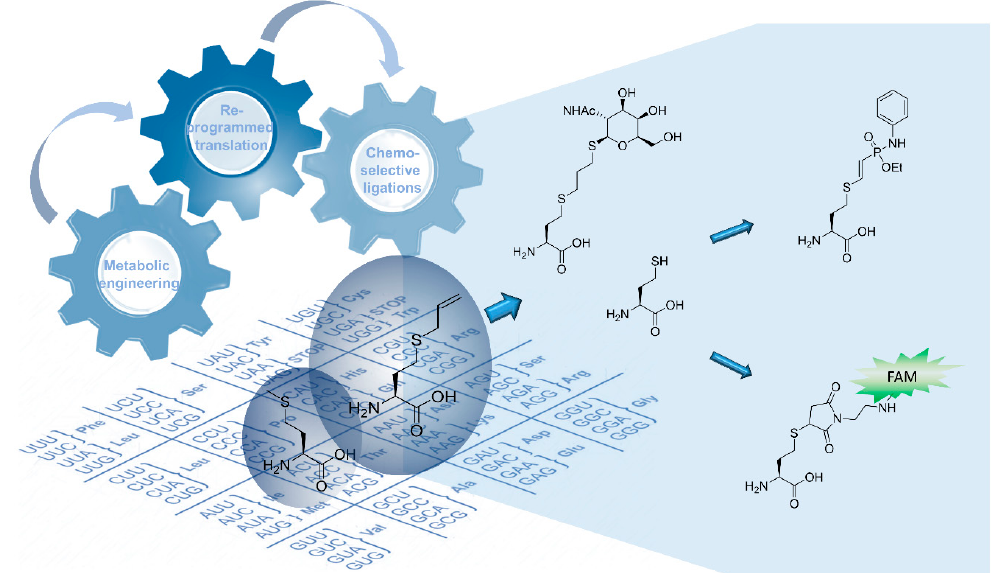
Figure A1. S-allyl-L-homocysteine (Sahc) is a small alkene bioorthogonal tag that can substitute Met in protein translation. We exploited a substrate tolerance of homocysteine synthetases from Corynebacterium glutamicum imported into Escherichia coli expression host enabling in situ Sahc production. Rewiring Met metabolic pathways towards intracellular noncanonical amino acid synthesis leads to an intracellular accumulation of Sahc and its subsequent incorporation into recombinant proteins, which are accessible to various bioorthogonal transformations.